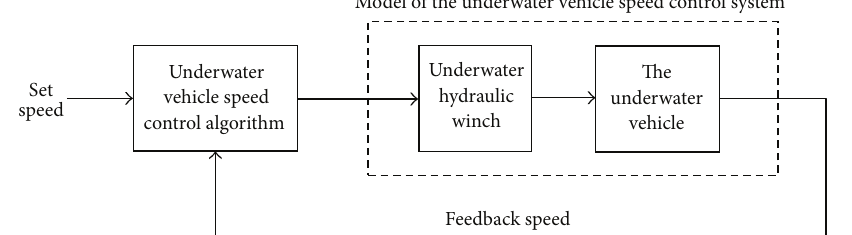
Figure 10: The schematic diagram of digital simulation.